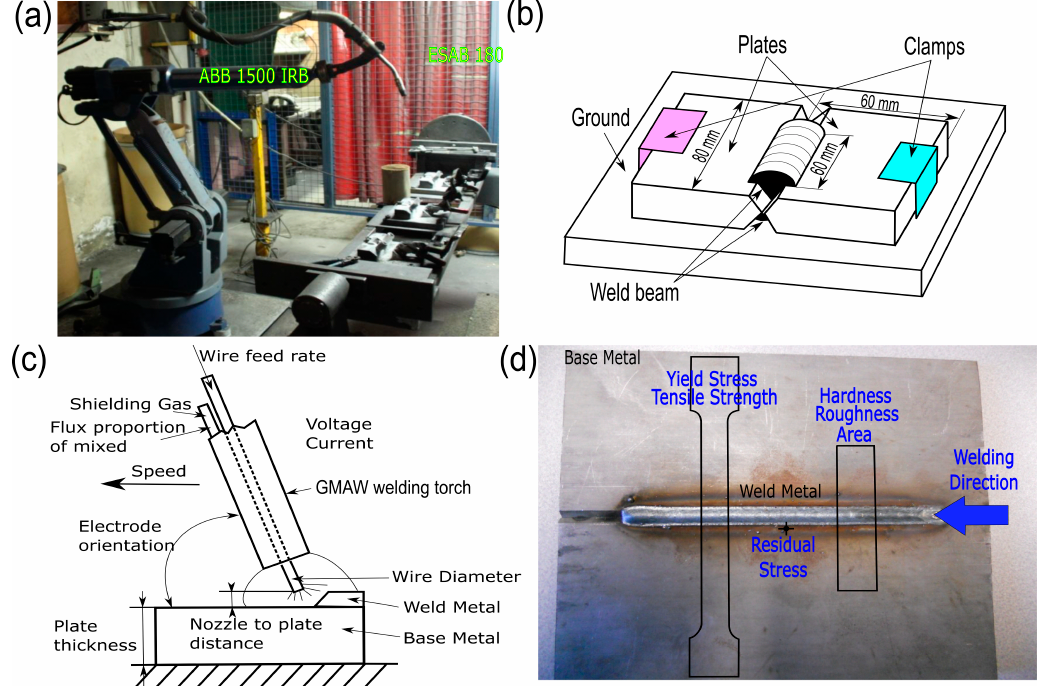
Figure 1. ( a ) ABB 1500 IRB robot with the ESAB 180 welding machine used to manufacture all welded joints with gas metal arc welding (GMAW). ( b ) The welding process employed in the manufacture of the butt joint with complete penetration (X-groove). ( c ) Common welding parameters used in GMAW and considered in this case. ( d ) Butt joint with complete penetration (X-groove) manufactured: details of the specimens to be machined for the different welded joint characterization tests.